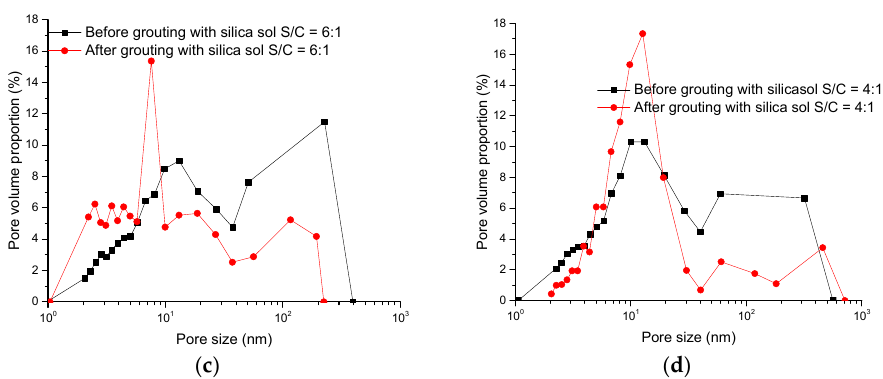
Figure 6. Mesopore analysis of samples before and after grouting with four different grouts. ( a ) Before and after grouting with P.O 425R; ( b ) before and after grouting with MP364; ( c ) before and after grouting with silica sol S/C = 6:1; ( d ) before and after grouting with silica sol S/C = 4:1.